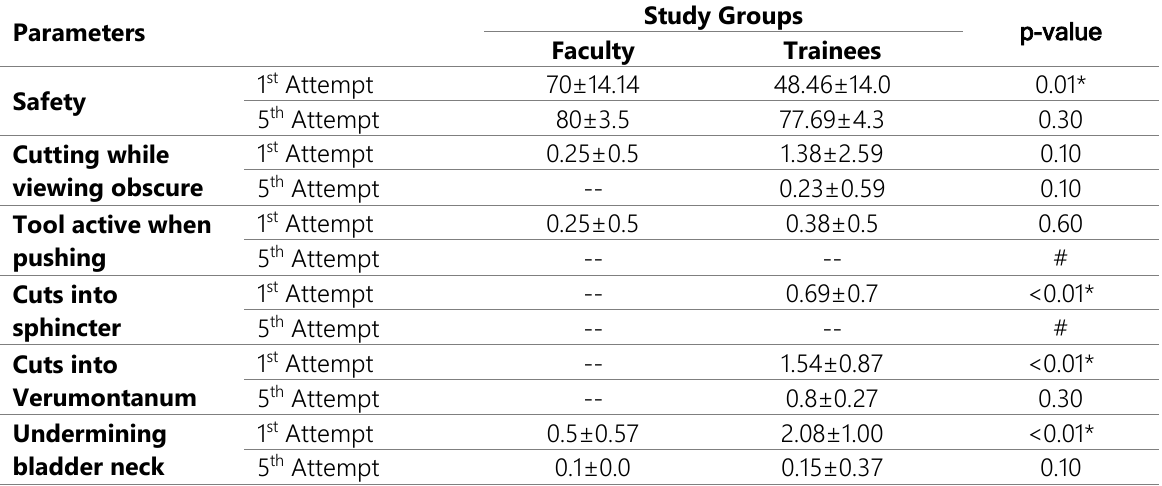
Table 3: Comparative findings of Simulative TURP- Safety among urology faculty & trainees.